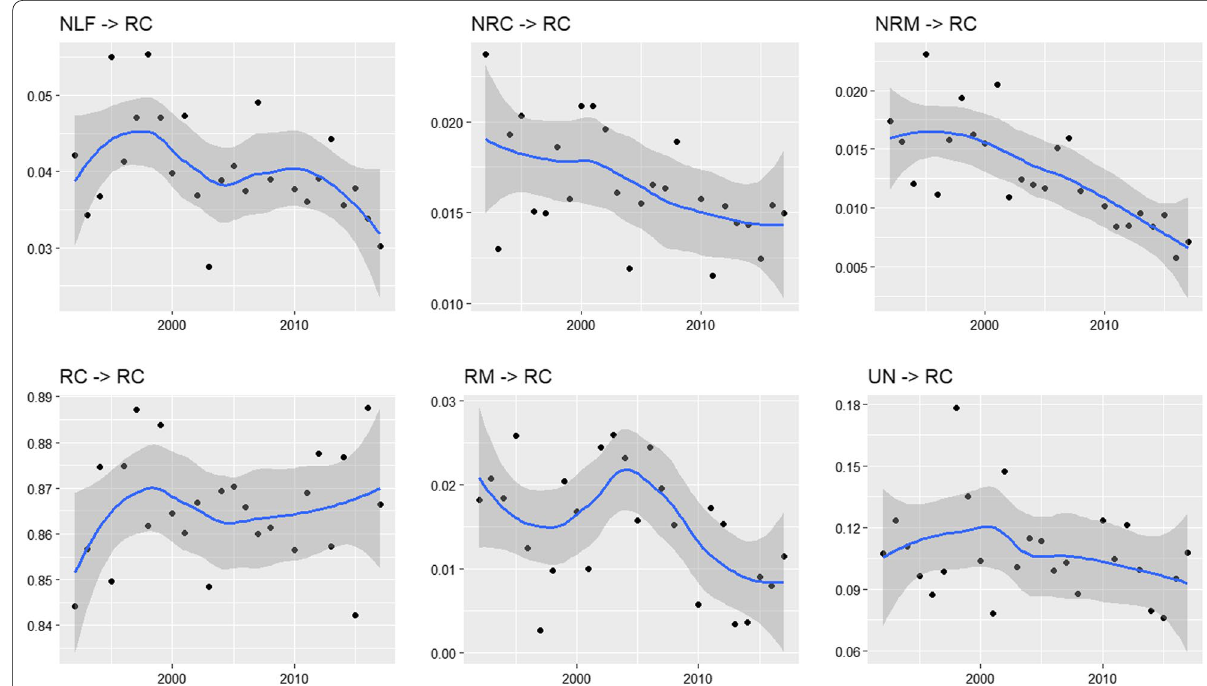
Fig. 5 Transition Rates for Inflows into Routine Cognitive Jobs. Notes: Transition rate computation is explained in chapter 3.2, blue lines show local regression lines, and the gray area marks the 95% confidence interval. The figure also includes the stayer rate (RC → RC), the share of routine cognitive workers remaining in routine cognitive employment. Source: Swiss Labour Force Survey, 1992–2018